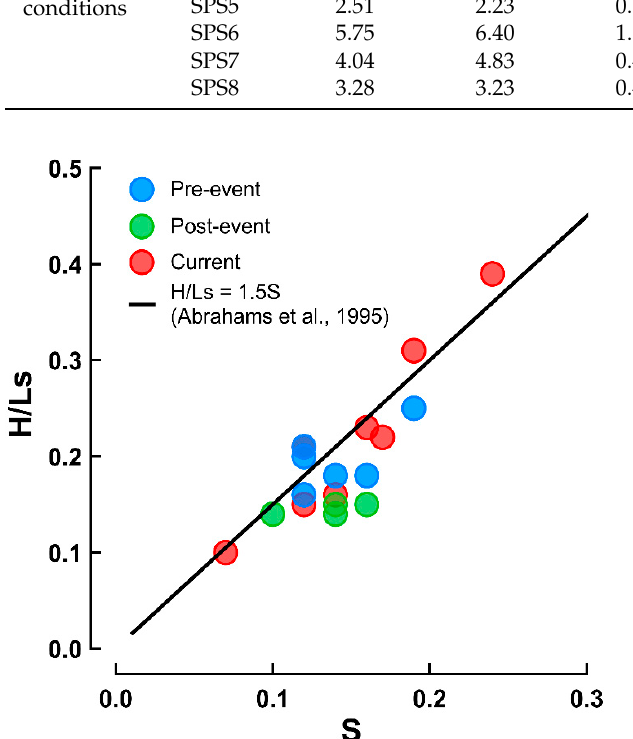
Figure 8. Grain size distributions of Rio Cordon surficial material measured pre-event, post-event, and in the current conditions.